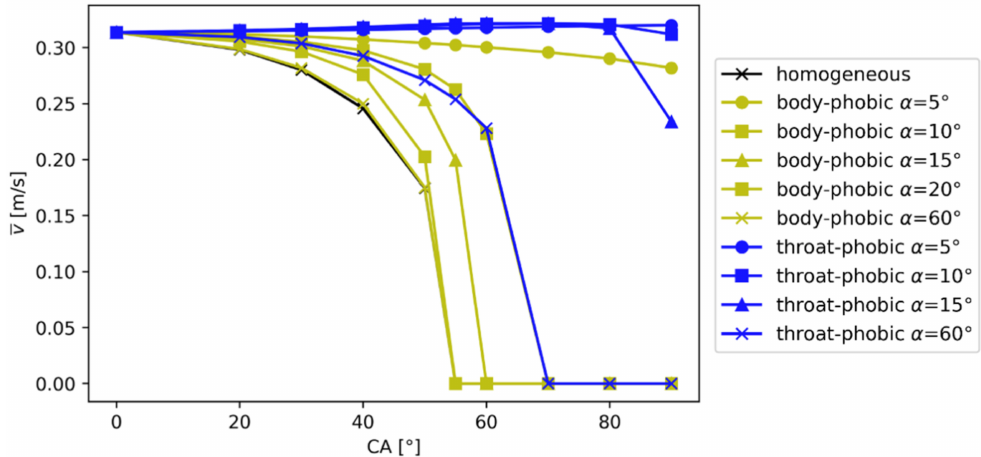
Figure 14. Average infiltration velocity v as a function of CA for body-throat coating patterns to compare the effects of body-phobic and throat-phobic coatings. The CA refers to those compartments of the particle surface whose wettability is